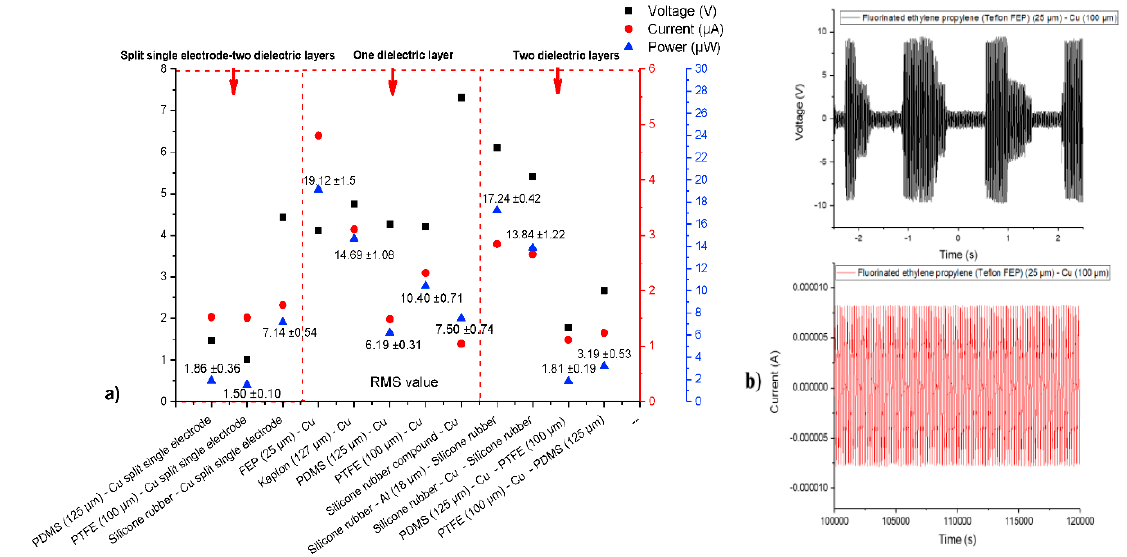
Figure 3. ( a ) Comparison of the outpu t voltage (V RMS ), current (I RMS ) a nd average output power of the WDSE-TENG prototypes with three configurations exposed to 1.2 Hz water wave impact. ( b ) Instantaneous output voltage (V) and current (I) of the WDSE-TENG using a FEP dielectric